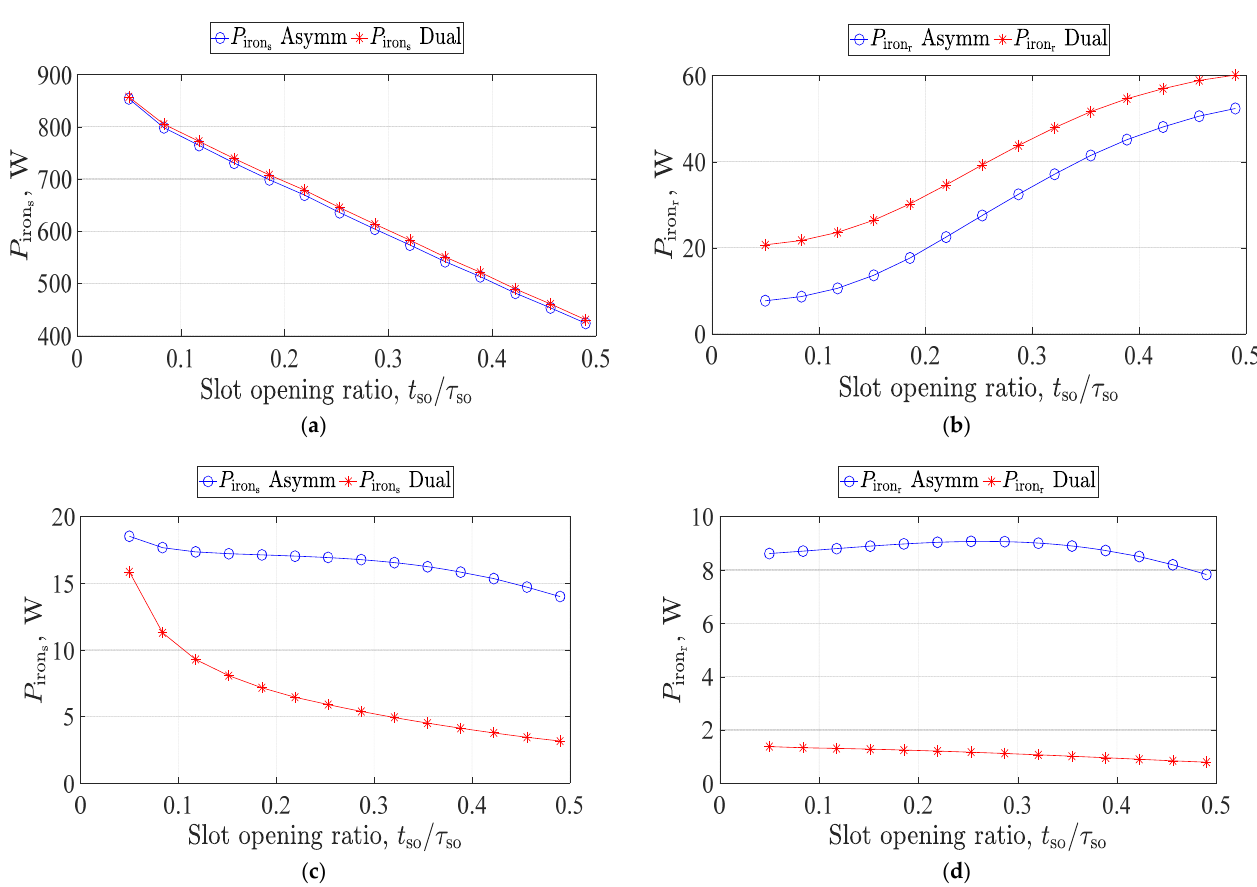
Figure 8. Variation in stator and rotor core losses with slot opening width under various operational modes. ( a ) Stator iron losses under propulsion. ( b ) Rotor iron losses under propulsion. ( c ) Stator iron losses under charging. ( d ) Rotor iron losses under charging.